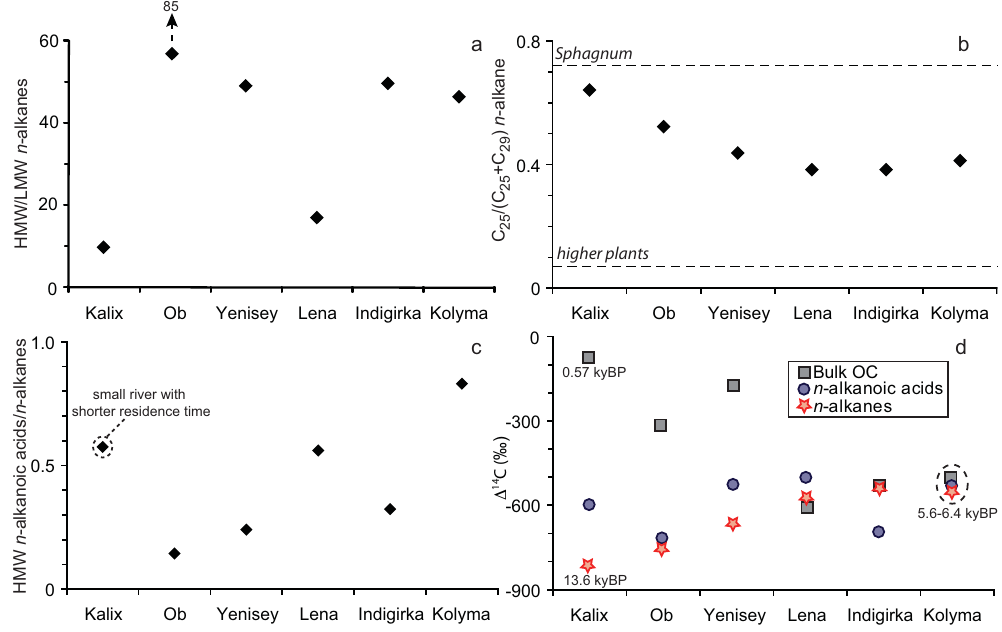
Fig. 2. Molecular and molecular-isotopic patterns of soil marker compounds from west-to-east across the Eurasian Arctic climosequence. (a) Ratio of terrigenous-to-aquatic derived n -alkanes (HMW n -alkanes to LMW n -alkanes). (b) C 25 /(C 25 +C 29 ) n -alkane ratio indicating contribution from Sphagnum -rich peatlands to the terrestrial OC (end-member values in Vonk et al., 2009). (c) Ratio of HMW n -alkanoic acids to HMW n -alkanes indicating an increased contribution of less degraded carbon eastward. (d) 1 14 C values of bulk OC, n -alkanoic acids (C 24 +C 26 +C 28 ) and n -alkanes (C 27 +C 29 +C 31 ) from estuarine surface sediments across the Eurasian Arctic. Uncertainties are smaller than symbols (see Table